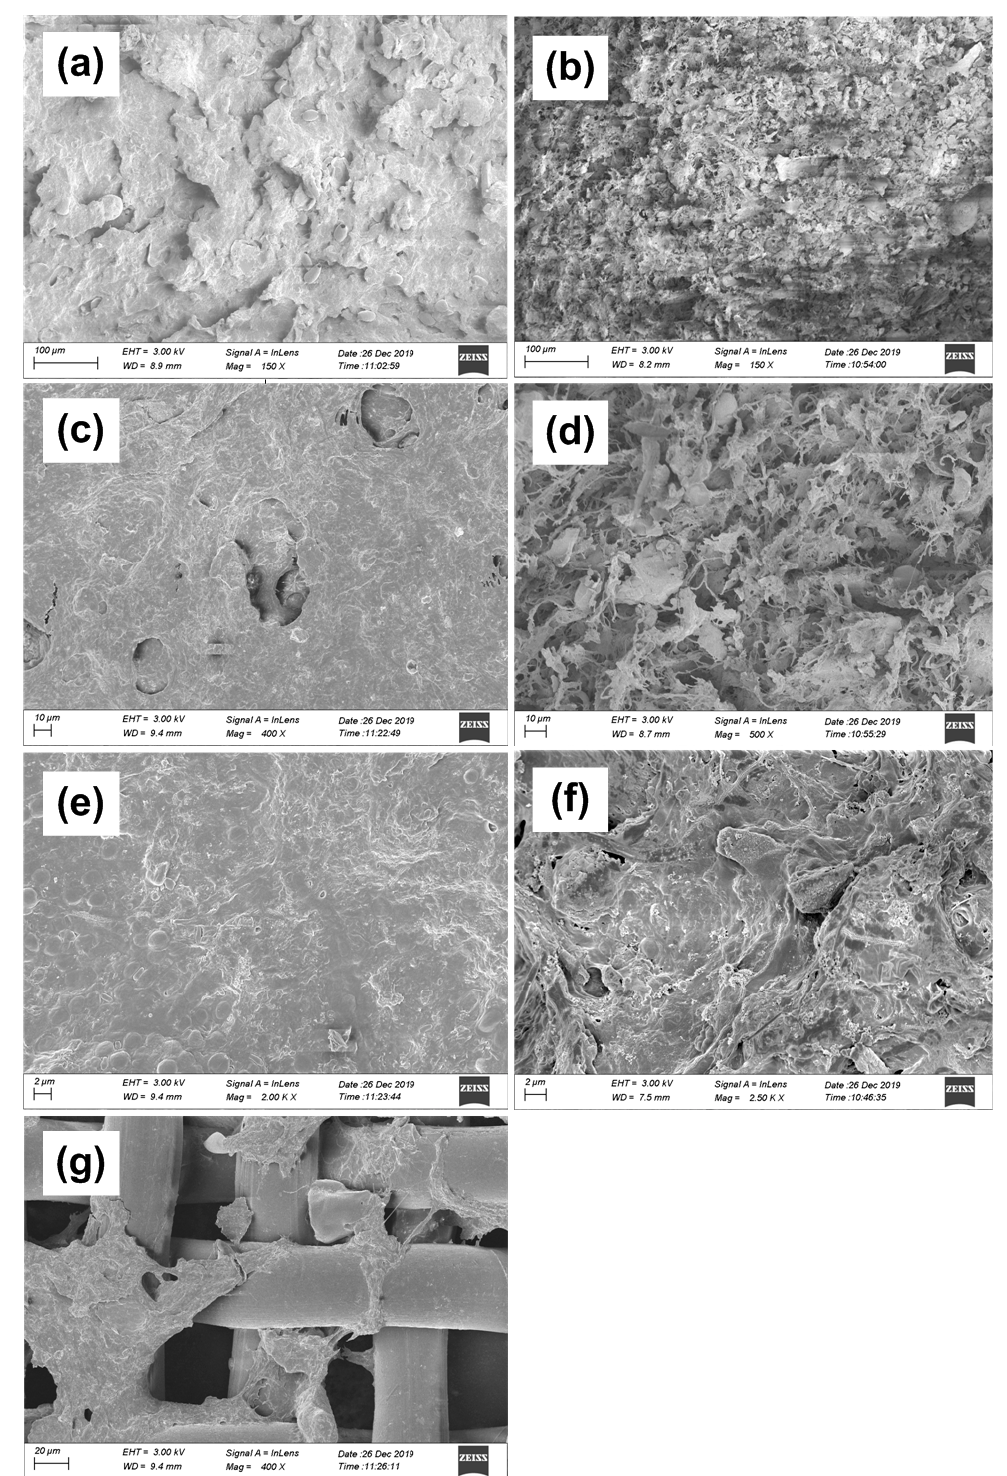
Figure 7. SEM images of the dynamic membrane samples of C-DMBR and PAC-DMBR ( a , c , e ) are cake layer for C-DMBR, ( b , d , f ) for PAC-DMBR, ( g ) the DM after the cake layer is scraped off.3.5. Model fitting of filtration cake.